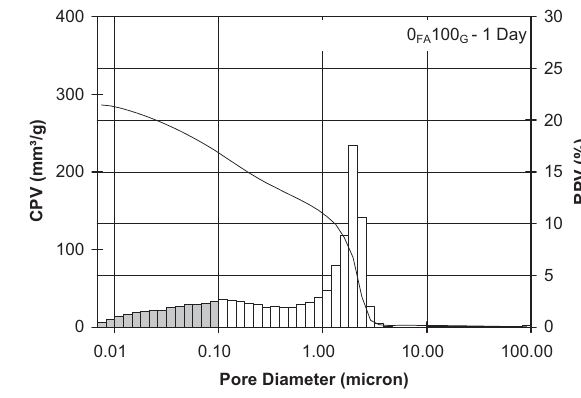
Fig. 6. Pore size distribution of paste P5